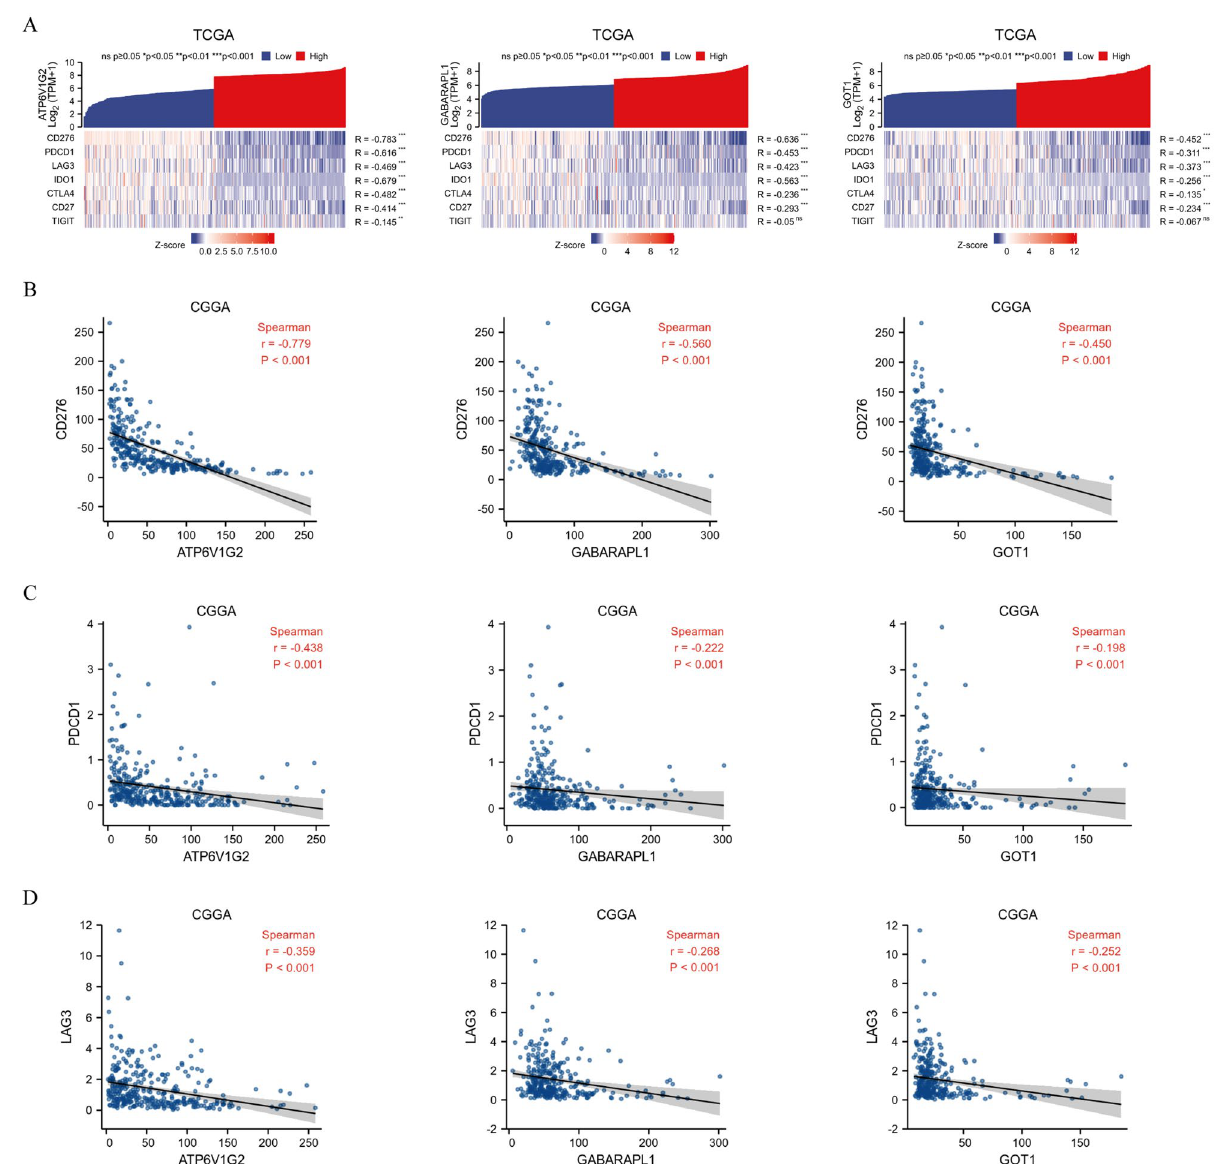
Figure 6. Visualization of the ICGs analysis. Association of hub genes with ICGs in TCGA database ( A ). Association of hub genes with CD276 ( B ), PDCD1 ( C ) and LAG3 ( D ) in CGGA